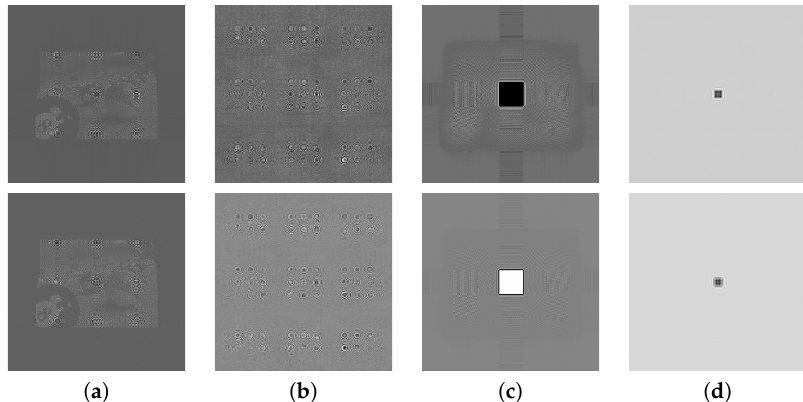
Figure 4. Fresnel transform results for holograms. Top four are real holograms and bottom ones are imaginary holograms. ( a ) Result of 1st Fresnel transform; ( b ) result of second Fresnel transform; Fresnel transform result of hologram after biasing. ( c ) Result of 1st Fresnel transform; ( d ) result of second Fresnel transform.